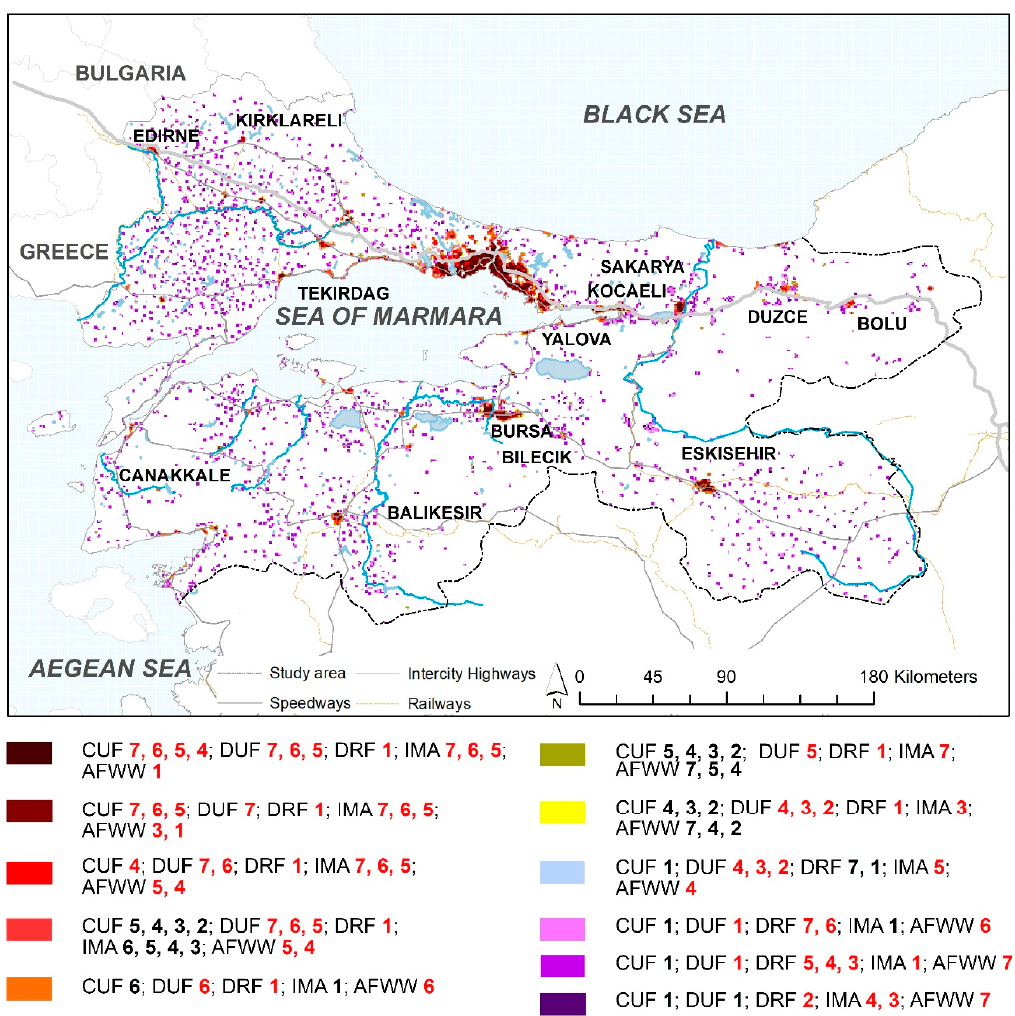
Figure 8. Urban fabric land cover composition in 2012.